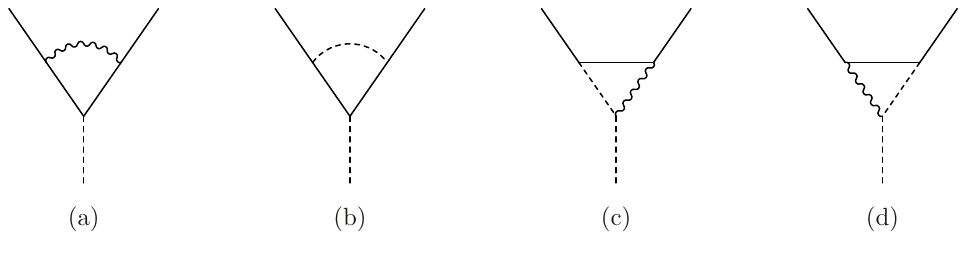
Figure 5. Vertex corrections to the couplings of neutral scalars to